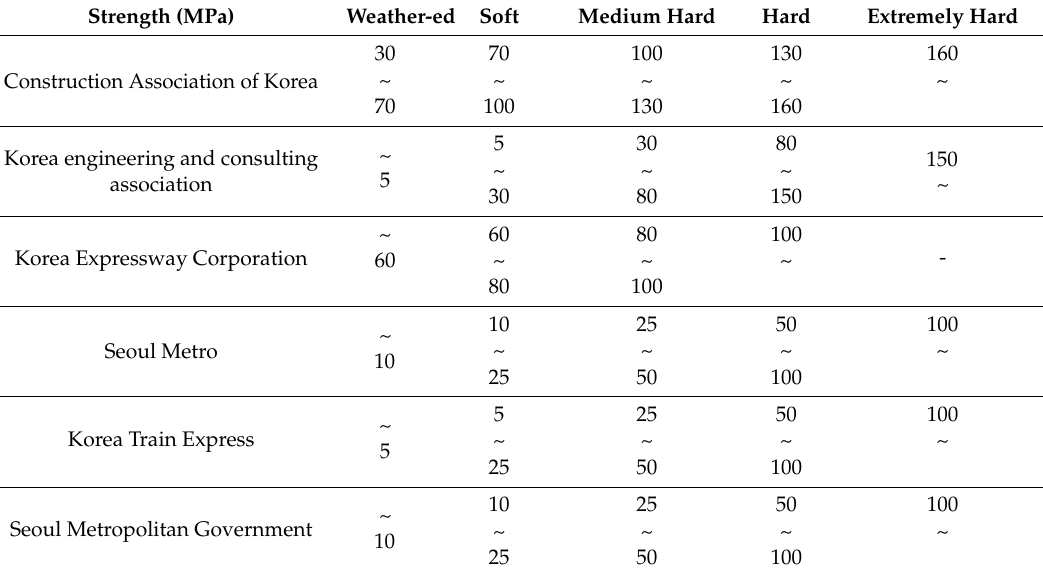
Table 2. Criteria of the rock according to uniaxial compressive